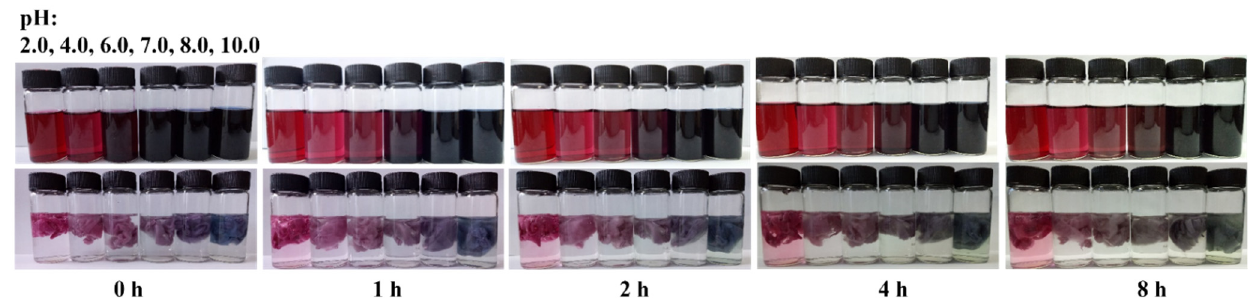
Figure 7. Physical appearance of the anthocyanin (top) and CA@Anthocyanin UFs (bottom) with various pH conditions (pH = 2.0, 4.0, 6.0, 7.0, 8.0, and 10.0) and various standing times (t = 0, 1, 2, 4, and 8 h).